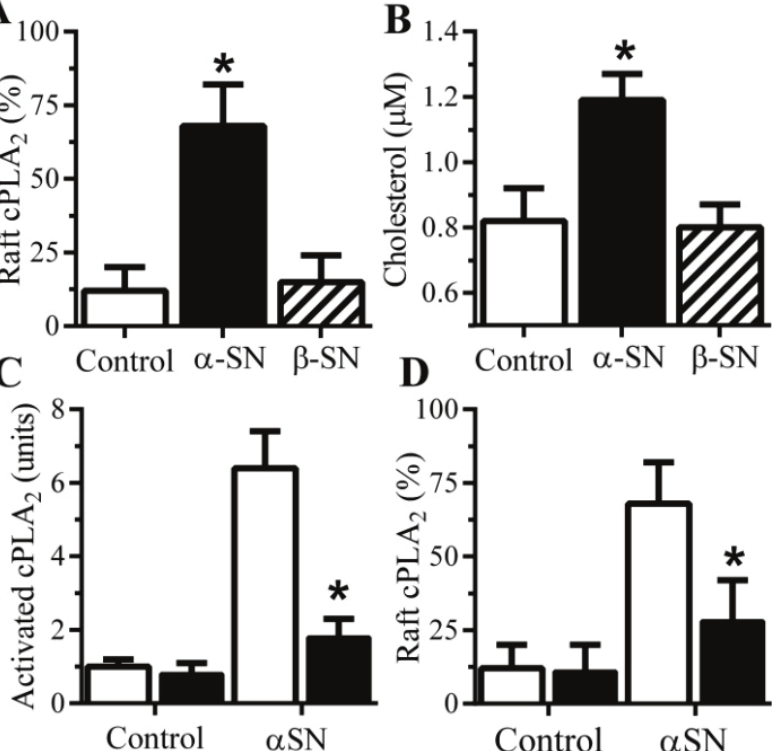
Figure 5. The (cid:2)SN-induced activation of synaptic cPLA 2 is sensitive to cholesterol depletion. ( A ) The amounts of cPLA 2 in rafts derived from synaptosomes incubated with control medium ((cid:6)) 1 (cid:8)M (cid:2)SN ((cid:7)) or (cid:3)SN (striped bar). Values are means ± SD from triplicate experiments performed three times, n = 9; *=significantly higher than in control synaptosomes. ( B ) The concentrations of cholesterol in synaptosomes incubated with control medium ((cid:6)) 1 (cid:8)M (cid:2)SN ((cid:7)) or (cid:3)SN (striped bar). Values are means ± SD from triplicate experiments performed three times, n = 9. * = significantly higher than in control synaptosomes. The amounts of activated cPLA 2 in synaptosomes pre-treated with control medium ((cid:6)) or 1 (cid:8)M squalestatin ((cid:7)) and incubated with 1 (cid:8)M (cid:2)SN or PLAP as shown. Values are means ± SD from triplicate experiments performed three times, n = 9; * = significantly lower than in control synaptosomes incubate with (cid:2)SN.( D ) The amounts of cPLA 2 in rafts derived from synaptosomes from neurons treated with control medium ((cid:6)) or 1 (cid:8)M squalestatin ((cid:7)) and incubated with 1 (cid:8)M (cid:2)SN. Values are means ± SD from triplicate experiments performed three times, n = 9. * = significantly lower than in control synaptosomes incubated with